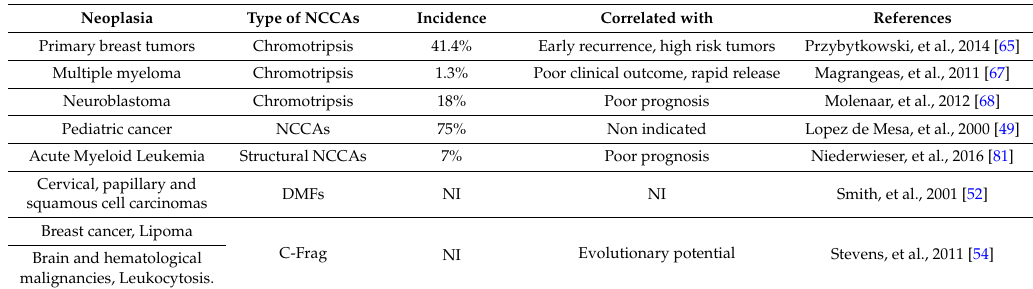
Table 2. Some non-clonal chromosomal alterations (NCCAs) observed in both solid tumors and lymphoid